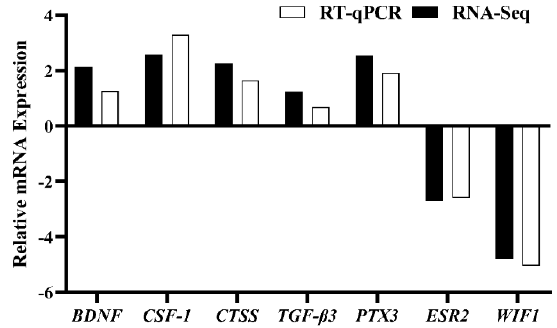
Figure 6. Validation of DEGs by RT – qPCR.